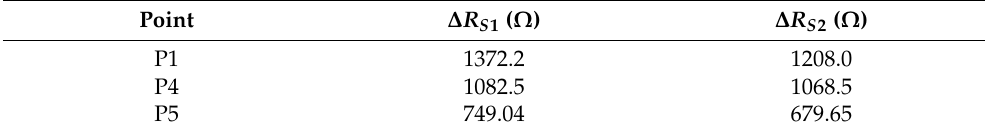
Table 2. Simulated resistance variation of the four sensors, depending on the force application